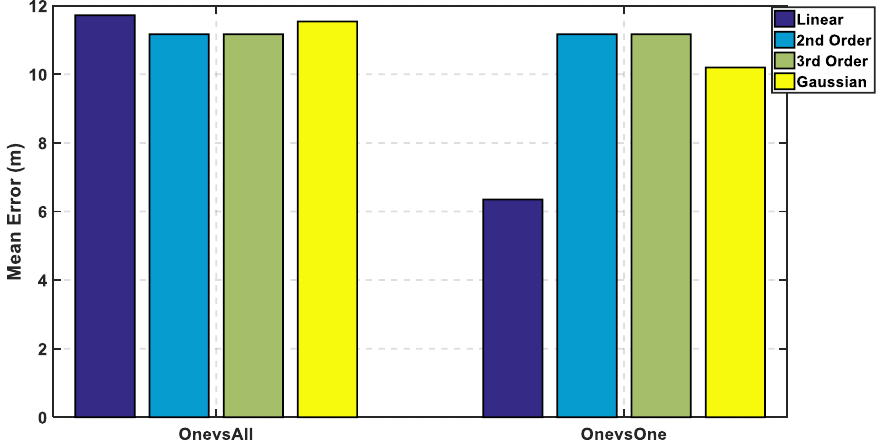
Figure 9. Mean Error for One-Versus-One and One-Versus-All Approaches for SVM at the 8th Principal Component.